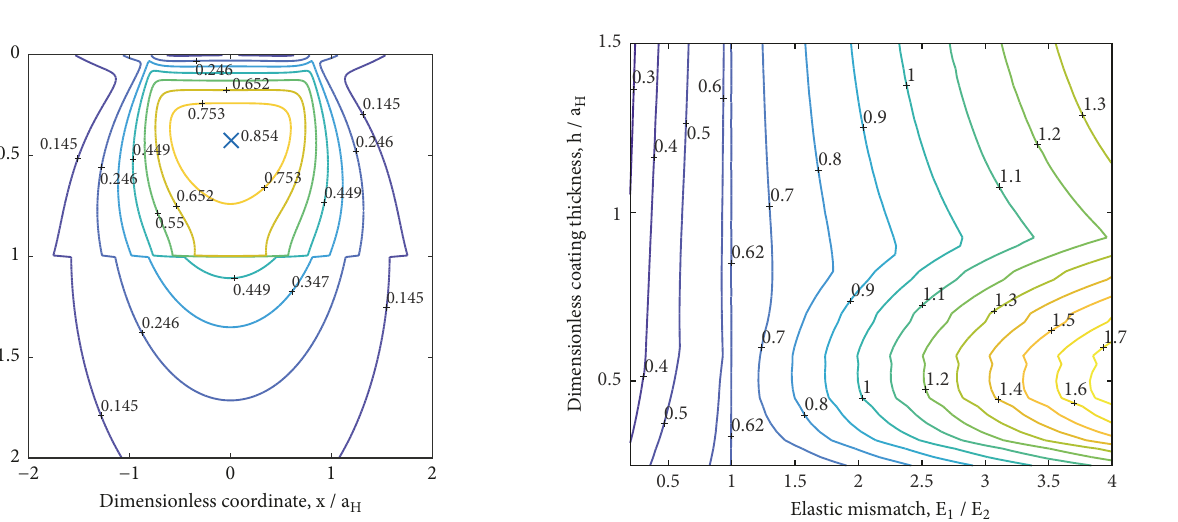
indicates that the maximum is located in the coating. For